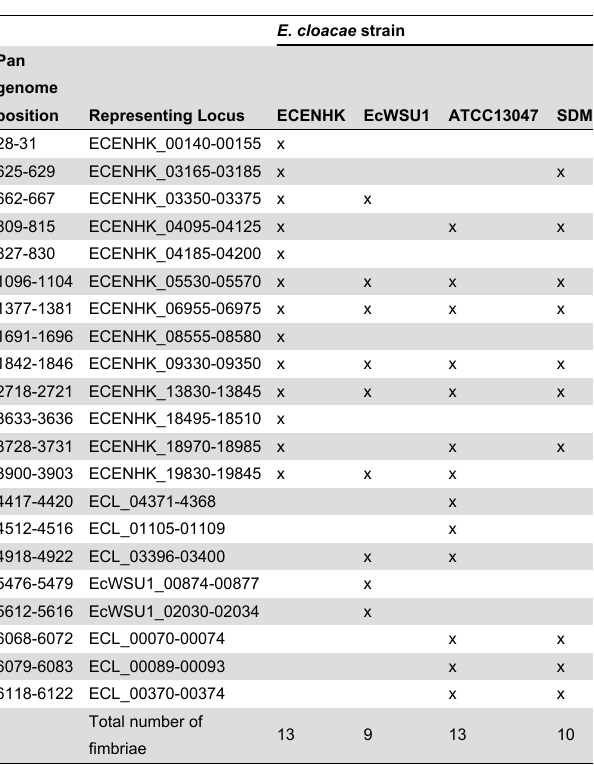
Figure 3. Comparison of subsystem features between E. cloacae . Genome sequences of ATCC13047, SDM, EcWSU1 and ENHKU01 were uploaded to the SEED Viewer server (http://rast.nmpdr.org/seedviewer.cgi) independently.